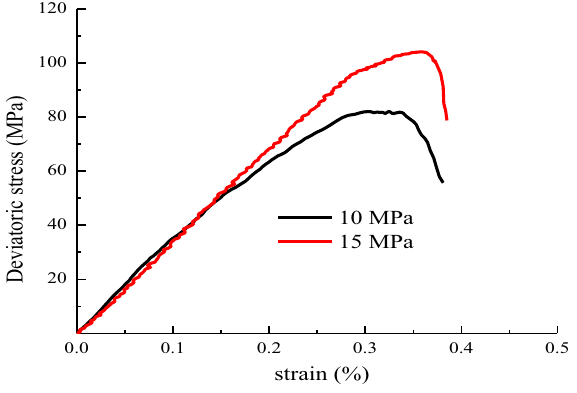
Figure 5. Deviatoric stress–strain relationship of conventional triaxial